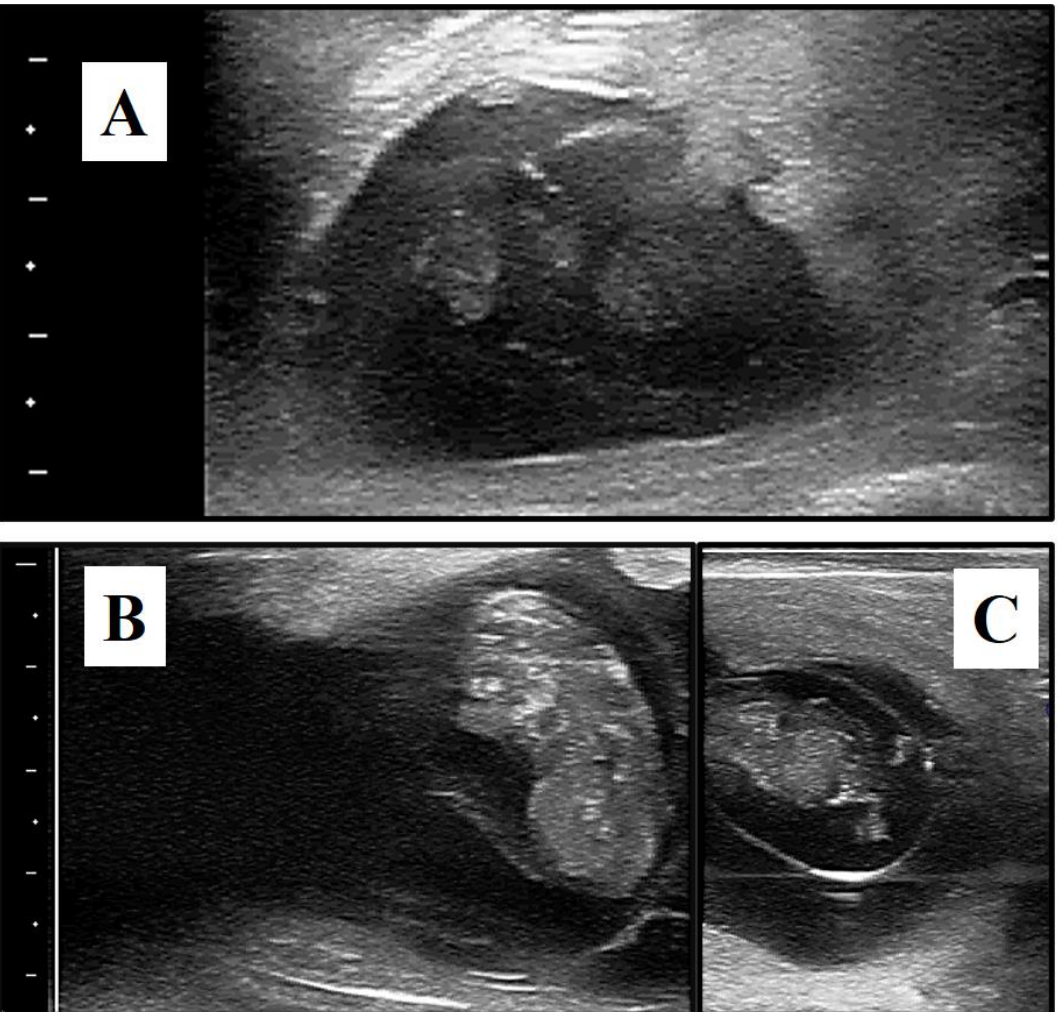
Figure 1. Sonograms showing signs of degeneration in both twins and turbidity of the uterine content 34 days post-AI ( A ) or one fetus seemingly of normal size and development ( B ) alongside its partner showing signs of deterioration such as floating hind limbs within the amnion at 52 days post-AI ( C ). Bar spacing: 10 mm. The independent variables recorded in each of the two treatment groups and effects of the different treatments on the induced abortion rate for both LE and EF cows are shown in Table 1. According to chi-squared tests, the LE group showed a significantly ( p < 0.0001) lower proportion of pluriparous cows (64.3%) and of cows treated during the warm season (21.6%) compared with the group of EF cows (94.6% and 47.5%, respectively). Estrus was detected in 285 LE cows (76%), all of which were inseminated, and 121 (42.5%) became pregnant following AI. The estrus response rate was significantly lower ( p < 0.0001) in the EF cows (27.9%) and significantly reduced ( p = 0.007) in the EF PG1 (22.4%) group compared with the EF PG1.5 group (39.2%). Estrus was detected significantly (ANOVA and Tukey post-hoc test: p < 0.0001) earlier in LE cows ( n = 285; 2.8 ± 0.9 days) than in